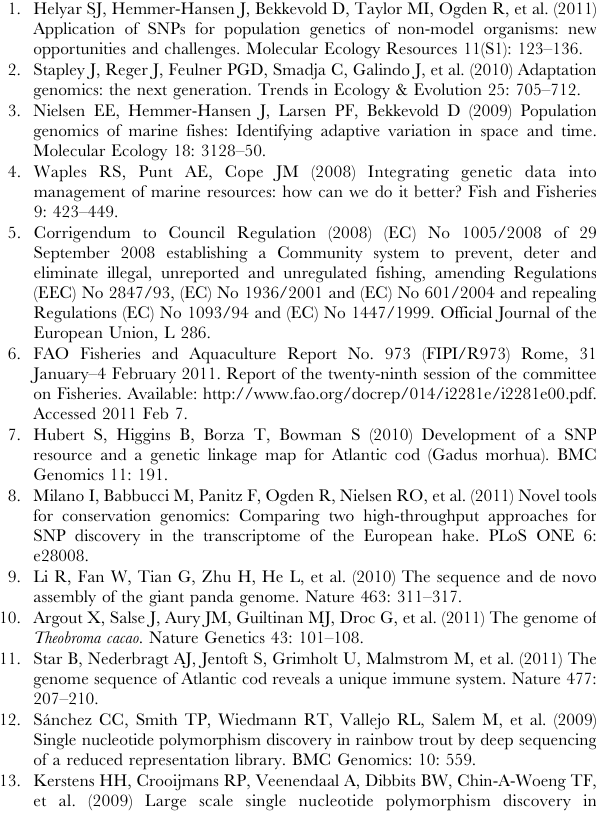
Table S3 List of the microsatellites for which primers were successfully designed, along with up to 200 bases flanking